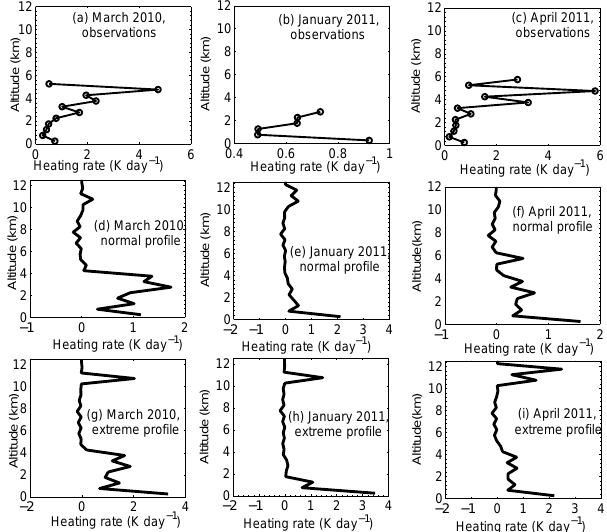
Figure 9. Vertical profiles of atmospheric heating rates correspond- ing to the observed BC profiles during (a) March 2010, (b) Jan- uary 2011 and (c) April 2011. Similar vertical profiles of atmo- spheric heating rates corresponding to the model-simulated BC pro- files during (d, g) March 2010, (e, h) January 2011 and (f, i) April